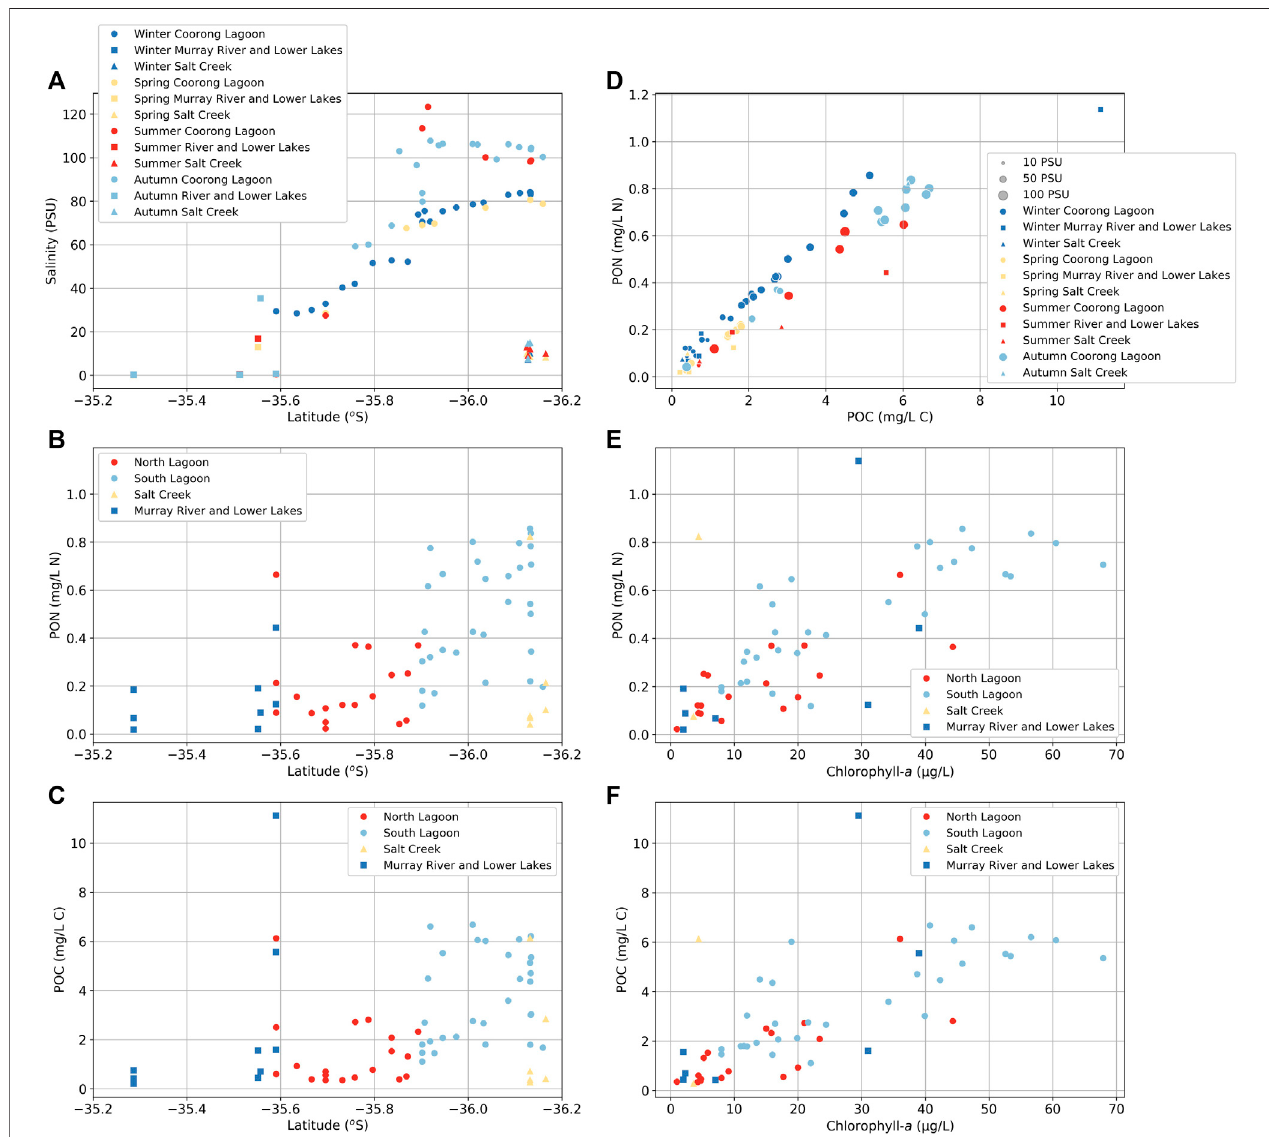
FIGURE 3 | (A) Salinity plotted along sample latitude showing sampling season. (B) Particulate organic nitrogen (PON) concentrations and (C) particulate organic carbon (POC) concentrations plotted against sample latitude. (D) PON against POC showing sampling season. (E) PON concentrations and (F) POC concentrations plotted against chlorophyll-a